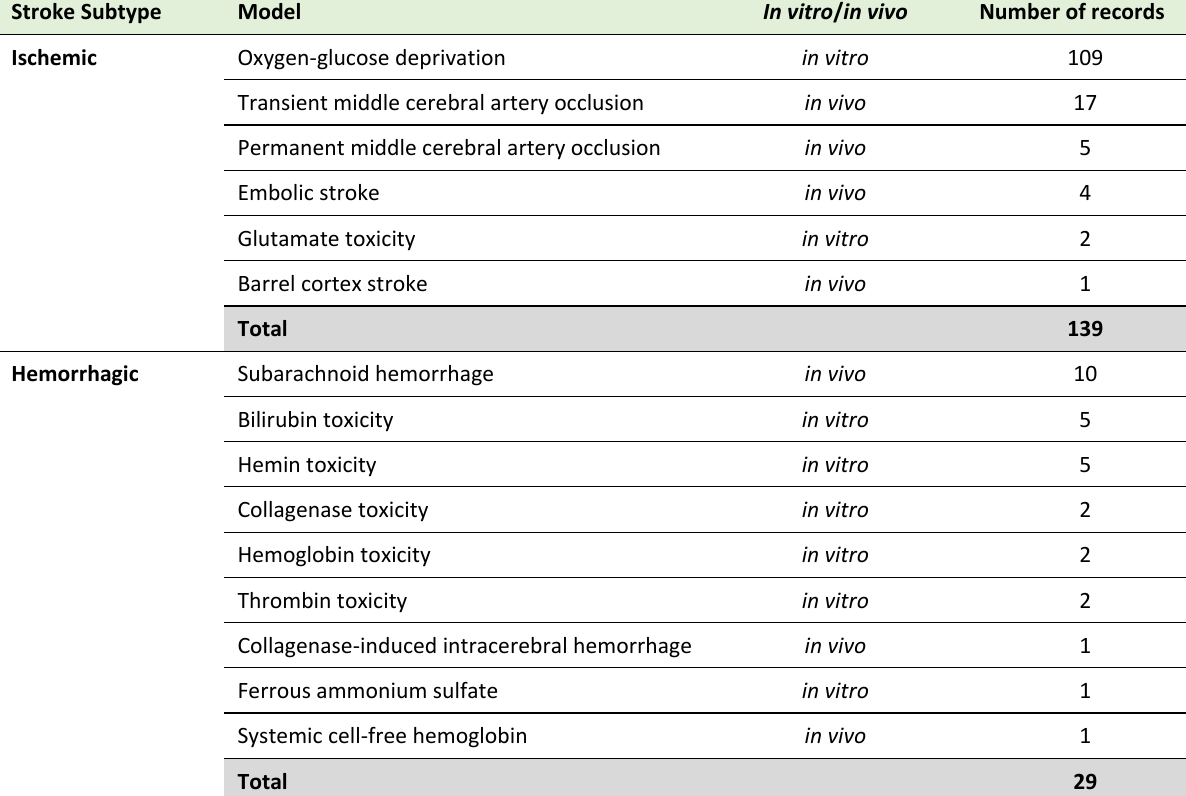
TABLE 1. Distribution of records according to experimental models used. Stroke